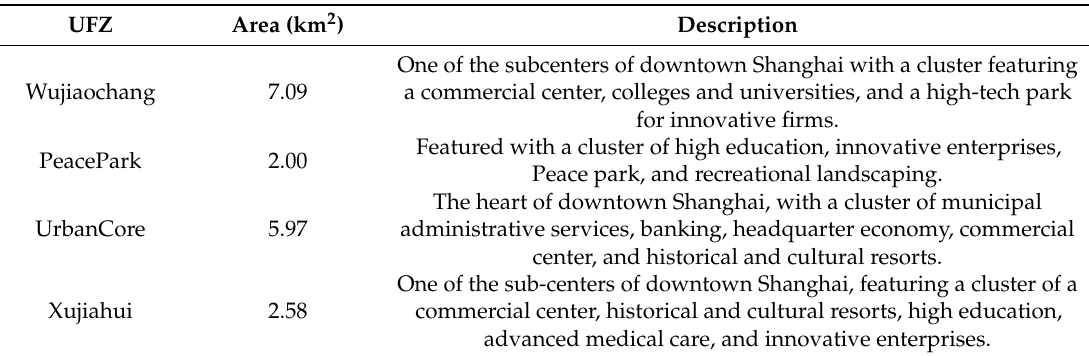
Figure 1. Location of the study area. Note: The labels ( a ), ( b ), ( c ), and ( d ) denote the four urban function zones (UFZs) known as Wujiaochang, PeacePark, UrbanCore, and Xujiahui, respectively. Table 1. Description of four UFZs.